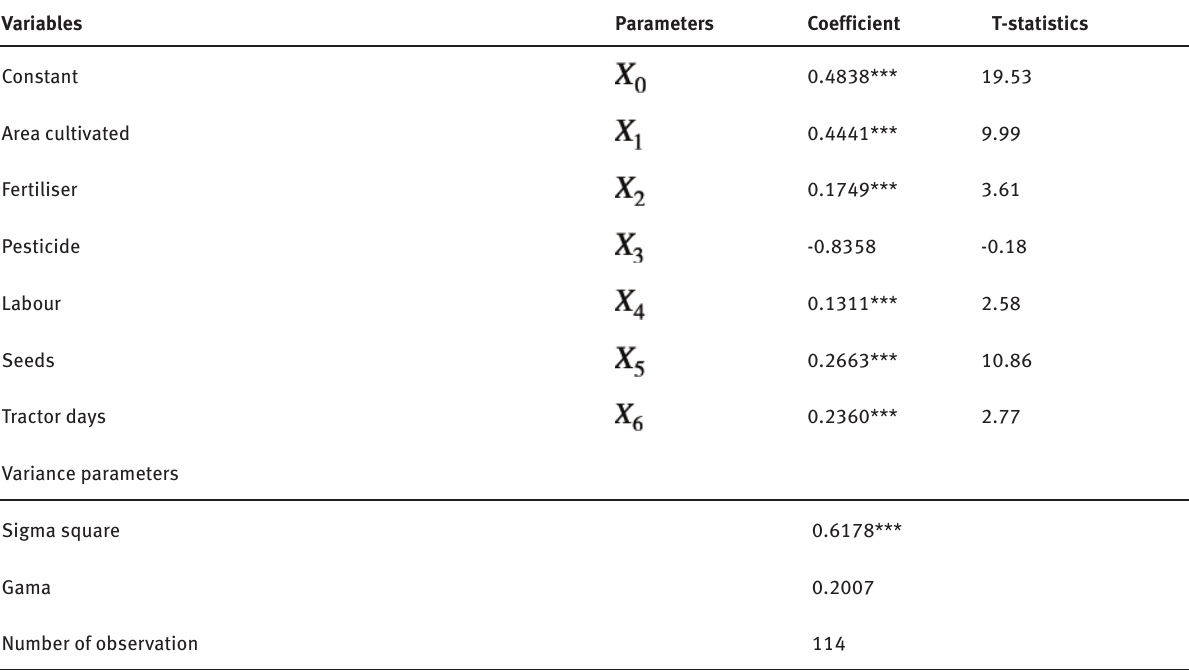
Table 4: Empirical results from Cobb-Douglas stochastic production frontier function